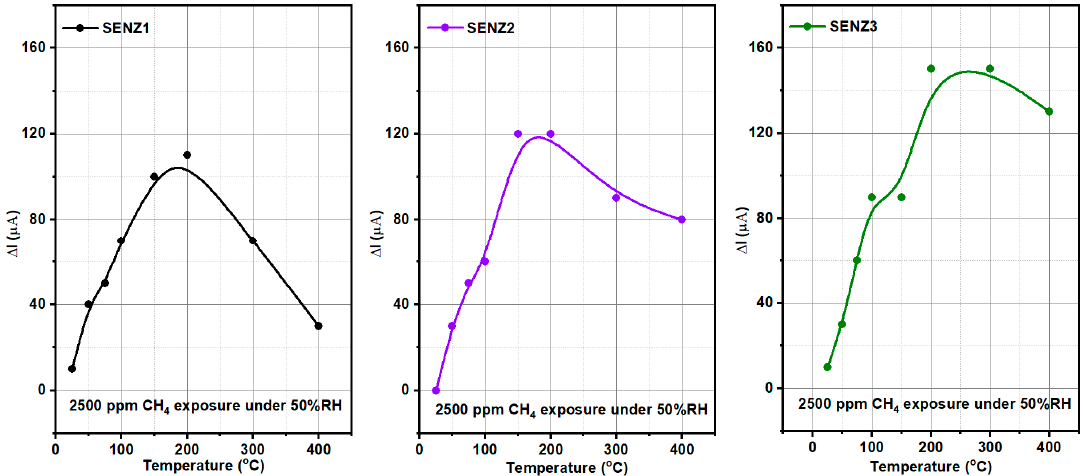
Figure 9. Conversion effects towards 2500 CH 4 exposure in three different catalytic micro-converters with respect to the operating temperature, where SENZ1 is 7Ce3Mn/10LaAl_pp; SENZ2 is 7Ce3Mn/10LaAl_cit and SENZ3 is 7Ce3Mn/10LaAl_imp.